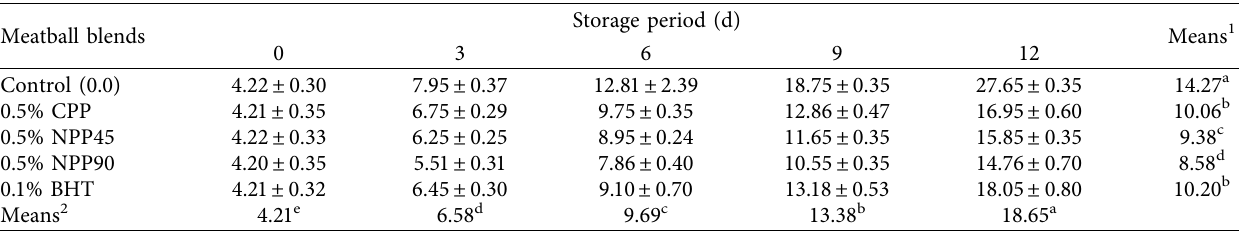
2 /100 gm sample) of cold stored meatballs.